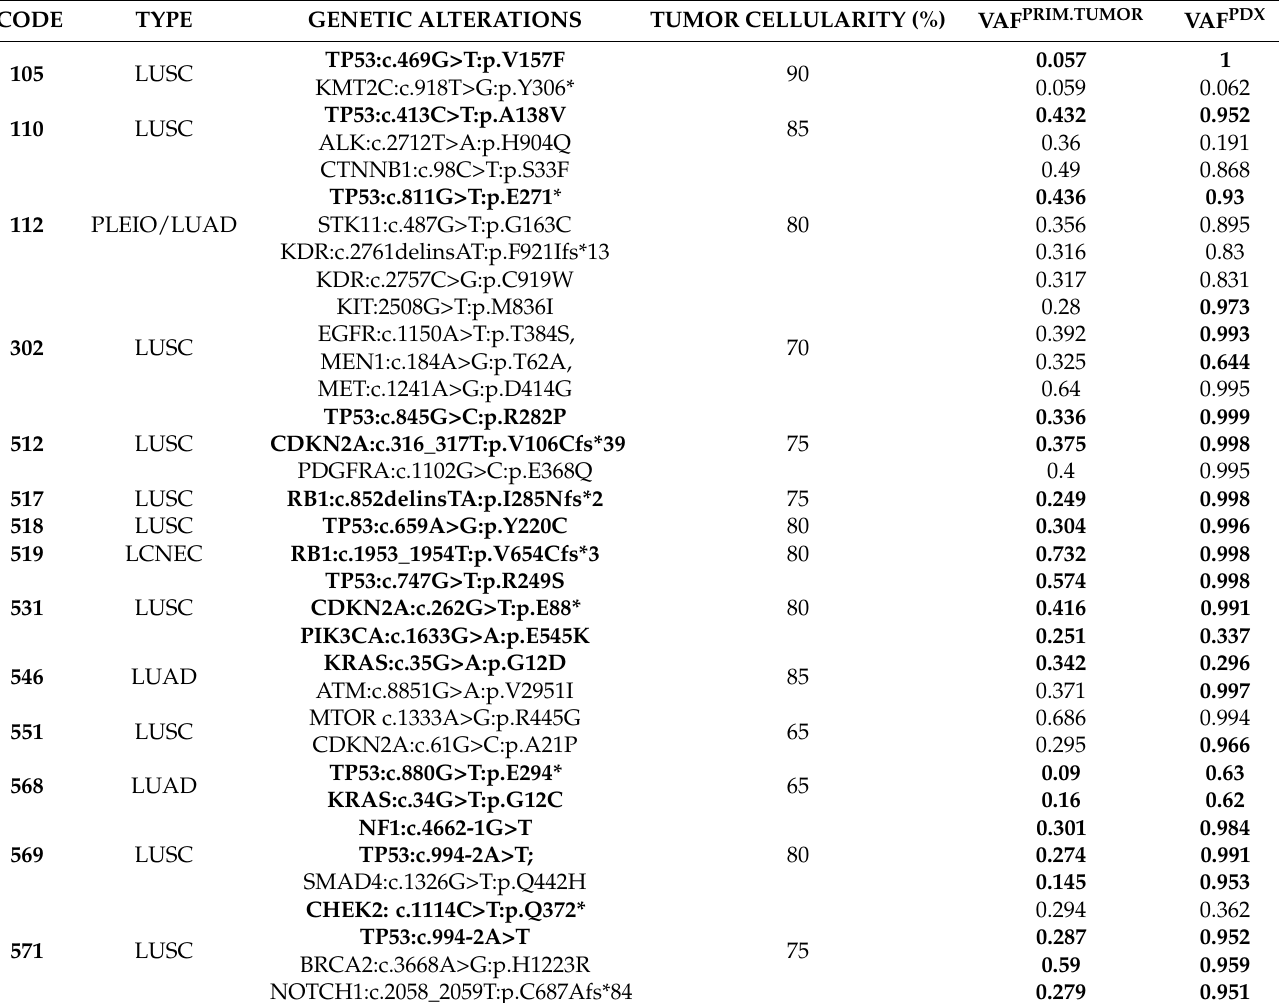
Table 4. Molecular differences between primary tumors and